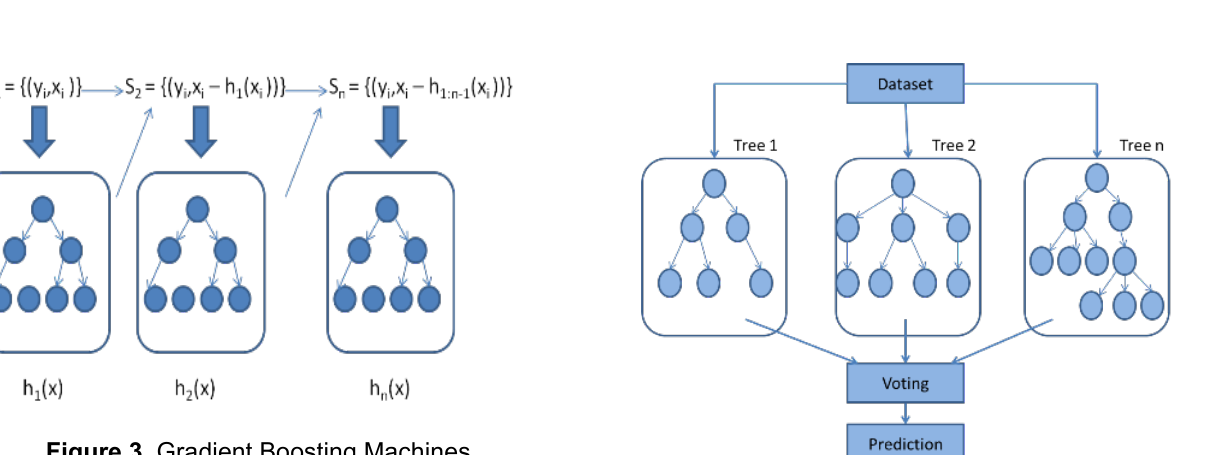
Figure 3 . Gradient Boosting Machines